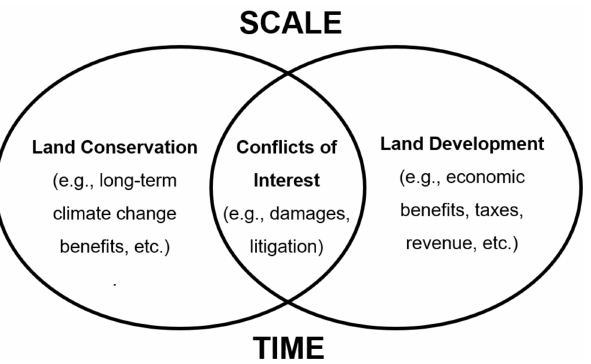
Figure 1. Conflicts of interest can be viewed as an intersection of different perspectives on land